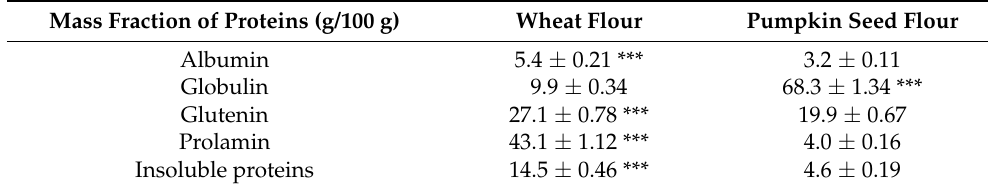
Table 1. Fractional composition of proteins of wheat flour and pumpkin seed flour. Data were compared with Student’s t -test ( p ≤ 0.05). Significance ***: p ≤ 0.001. Mass Fraction of Proteins (g/100